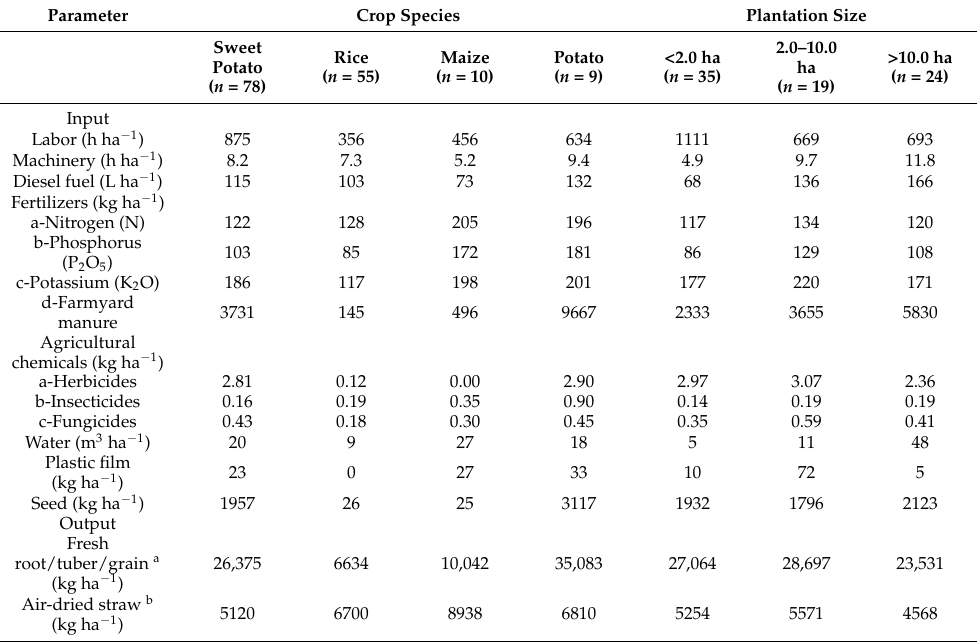
potato) and different plantation sizes of sweet potato production in